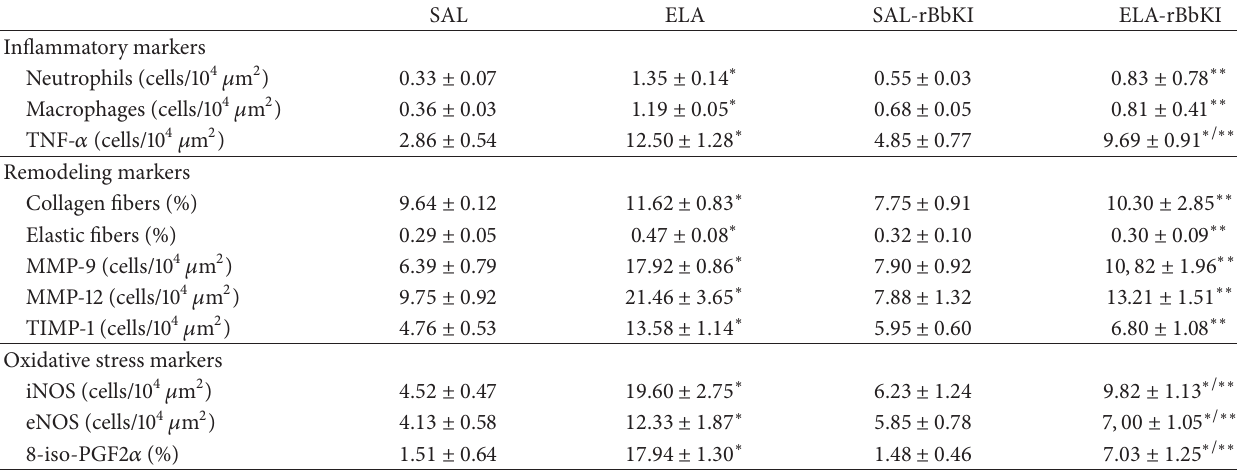
Table 2: Absolute values of the morphometric analysis for inflammatory, remodeling, and oxidative stress markers, in the alveolar walls. The neutrophils, macrophages, TNF- 𝛼 , MMP-9, MMP-12, TIMP-1, iNOS, and eNOS are expressed in positive cells/10 4 𝜇 m 2 . The collagen fiber, elastic fiber, and 8-iso-PGF2 𝛼 are expressed in percentage (%). ∗ 𝑃 < 0.05 , compared with the SAL and SAL-rBbKI groups; ∗∗ 𝑃 < 0.05 , compared with the ELA-rBbKI group.